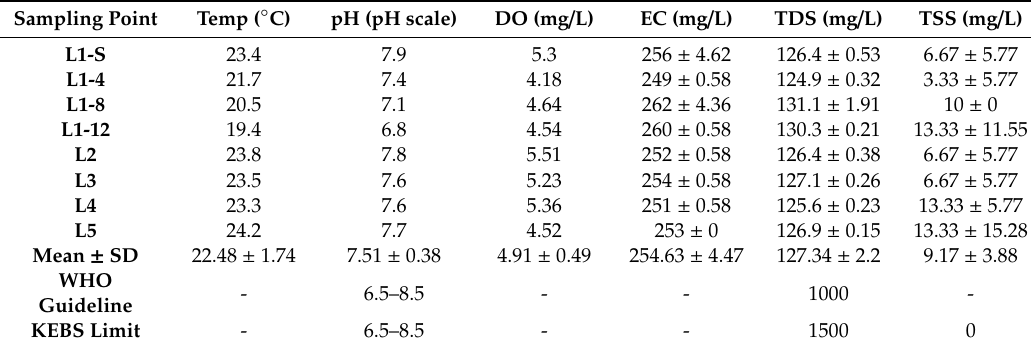
Table 3. Concentration of physical parameters in Rungiri quarry reservoir in January 2019.